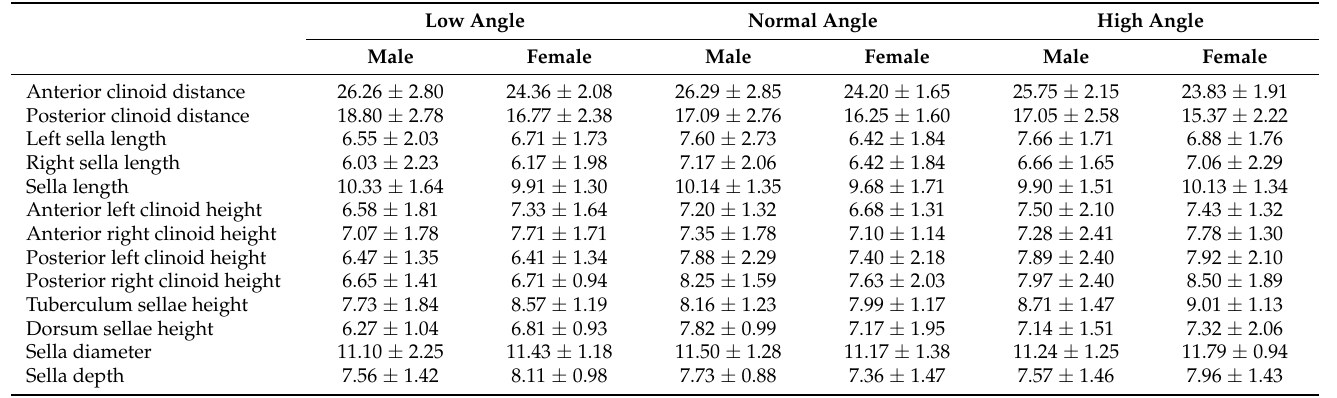
Table 7. Mean and standard deviation of sella turcica dimensions in genders within three groups.